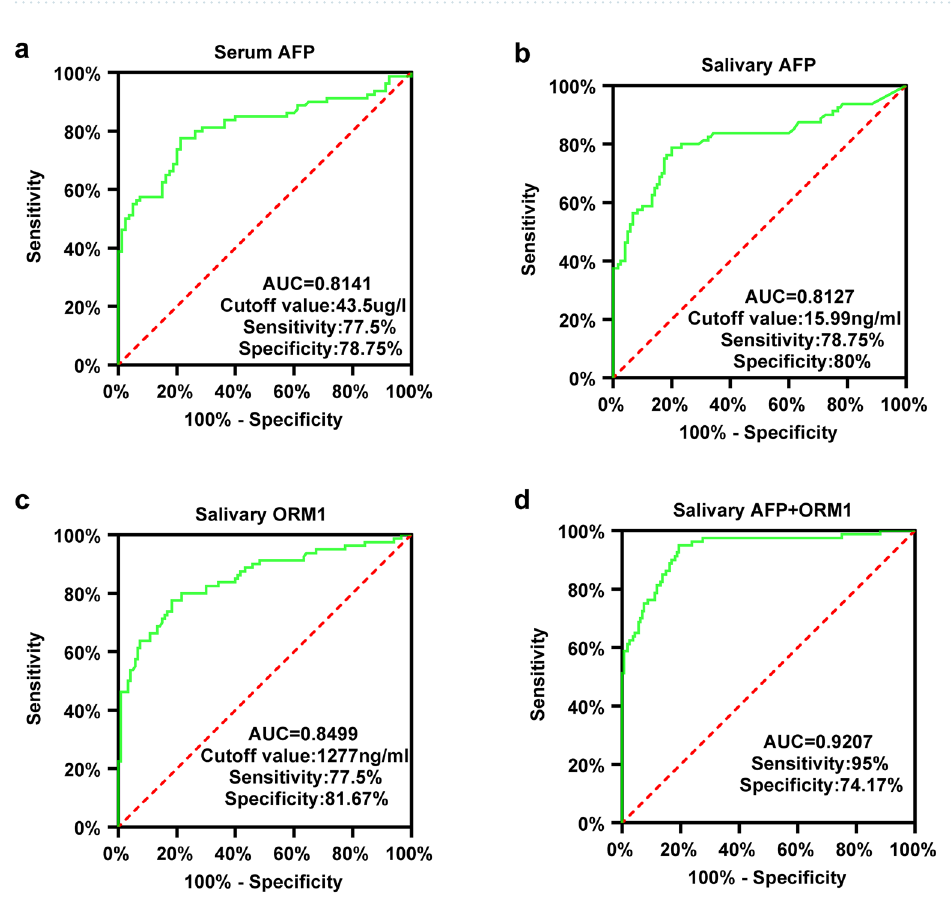
Figure 6. ROC curves. ( a ) The ROC curves of serum AFP in diagnosis HCC. ( b ) The ROC curves of salivary AFP in diagnosis HCC. ( c ) The ROC curves of salivary ORM1 in diagnosis HCC. ( d ) The ROC curves of saliva ORM1 and saliva AFP combination in diagnosis HCC. AFP α-fetoprotein, ORM1 Orosomucoid1, HCC hepatocellular carcinoma, LC liver cirrhosis, CHB chronic viral hepatitis B, ROC Receiver operating